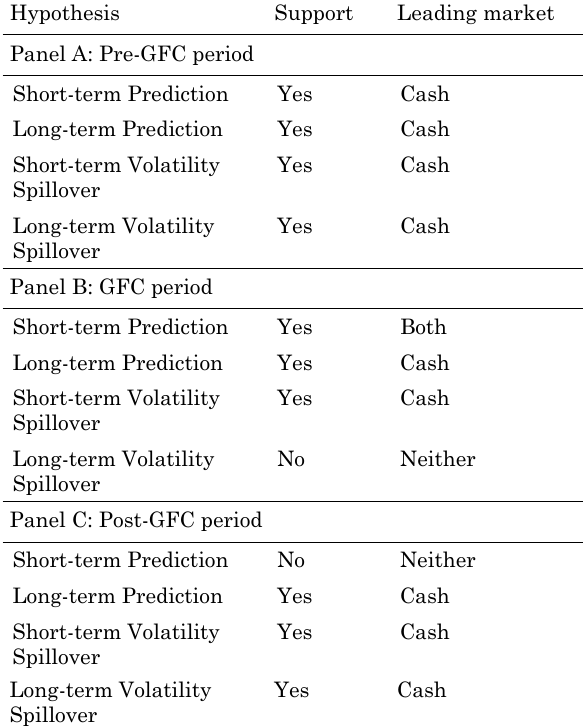
table 7. Summary results table for